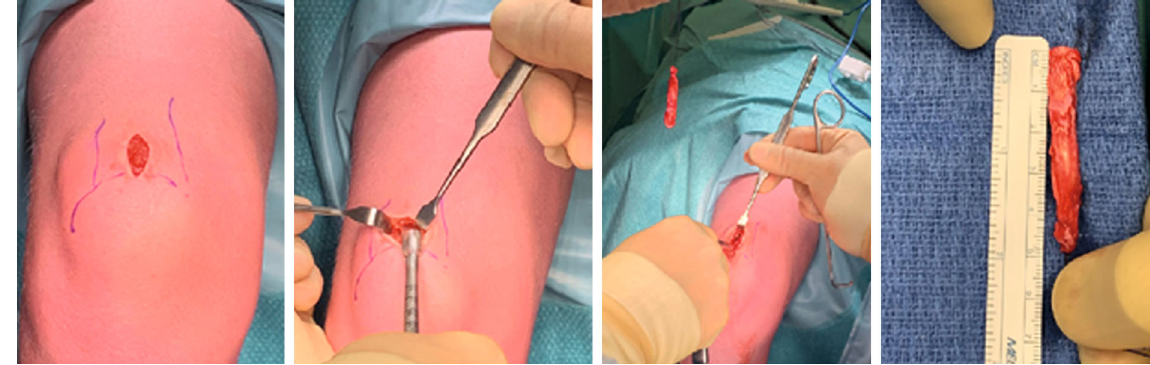
Figure 4: Quadricep tendon autograft was harvested in the minimally invasive technique.